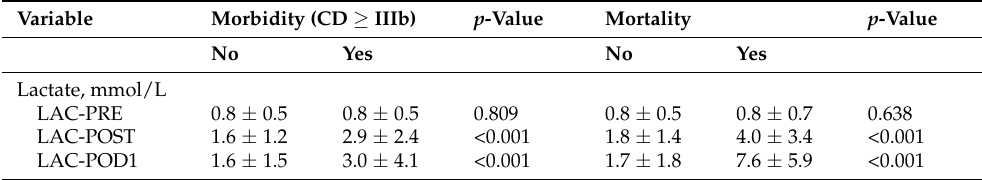
Table 3. Comparison of lactate levels and postoperative morbidity and mortality in 152 patients who underwent liver resection. of the postoperative outcome in 152 patients after liver resection. Variable